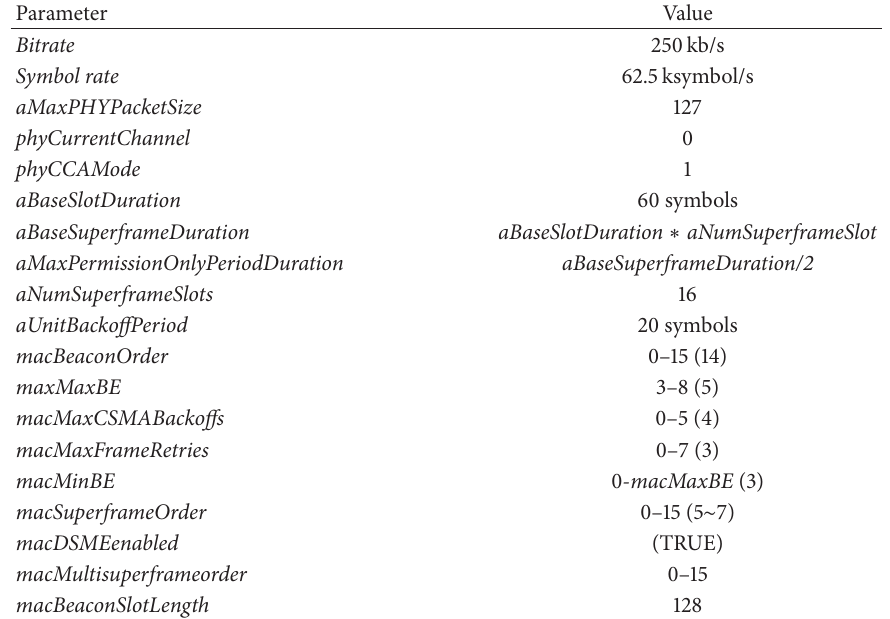
Table 3: Key parameters used in the